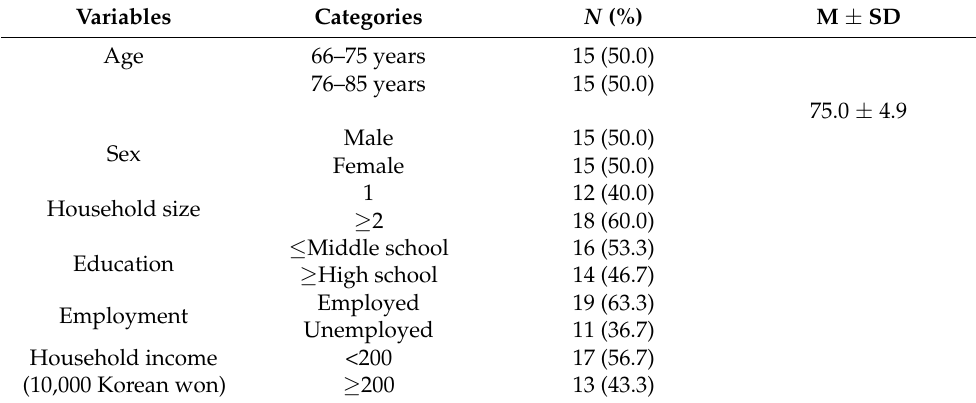
Table 1. General characteristics of participants ( N = 30).